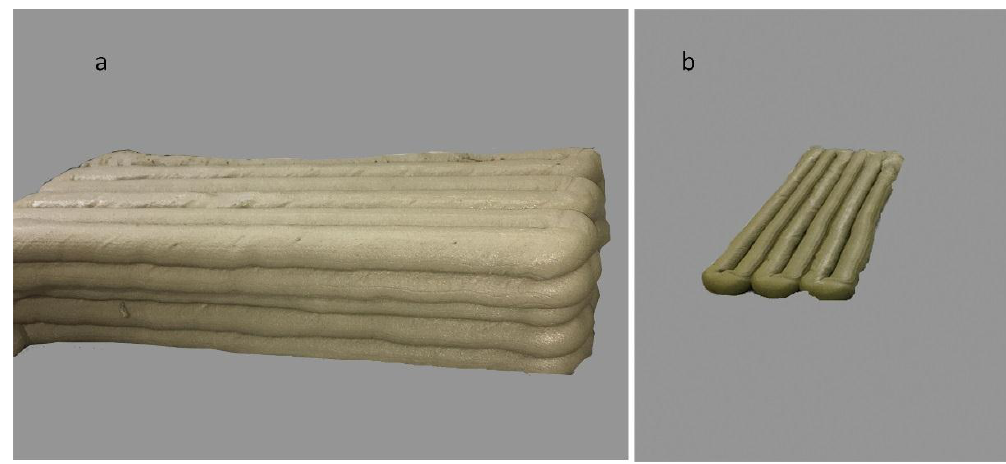
Figure 9. ( a ) Six layers of the printed object; ( b ) One layer of the printed object. For a printed object of over 120 mm (more than 7 layers), the oscillation at the arm of the robot increased in the end-tip of the arm which is most related to joint 4 and joint 6 in the robot [28]. Figure 10 shows how the printed layers collapsed after 10 layers of printing.